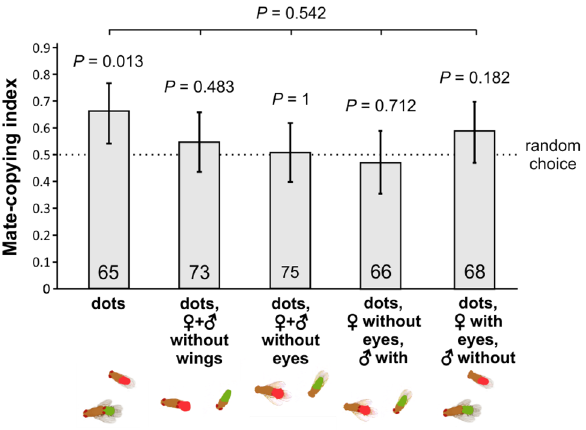
Figure 6. Effect of modifications on the dots treatment on mate copying. All treatment include a mixture of lateral or top views of the copulating pair. Statistics above bars: P values of the binomial tests of departure from random choice (represented by the dashed line); above the horizontal bars: P values of binomial tests of a GLMM testing the treatment effect within each panel. Error bars: Agresti-Coull 95% confidence intervals. For examples of the pictures used see Fig. 2b,d,e,f,g.